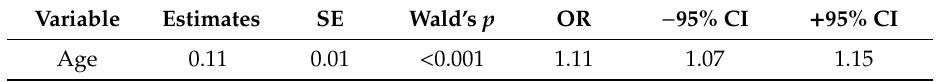
Table 2. Multivariate logistic regression analysis for poor sleep in patients with T2DM. Variable